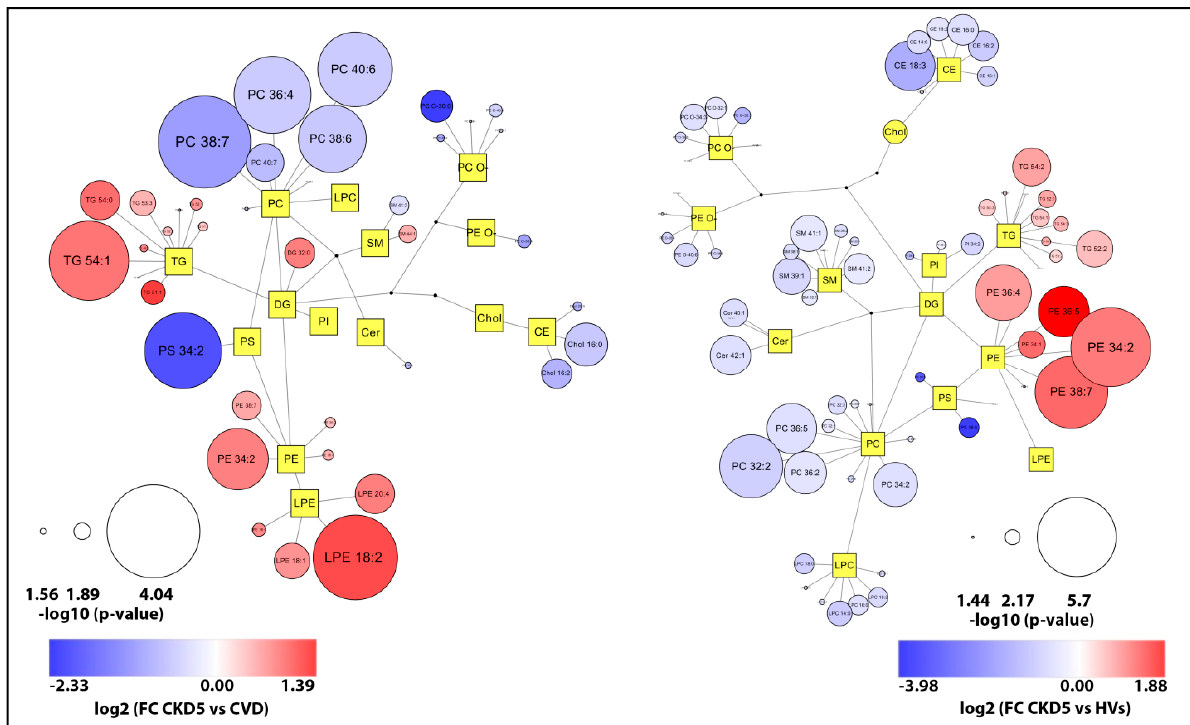
Figure 5. LION-term enrichment analysis of CKD1-2 vs. CVD, CKD5 vs. HV, CKD5 vs. CVD and CKD1-2 vs. HVs pre- sented in the “ranking mode”. The gray vertical lines indicate the threshold of –log10 False discovery rate (FDR)-corrected p -value 0.05 ( q -value 1.3). Red bars present terms with FDR-corrected p -value < 0.01 ( q > 2).